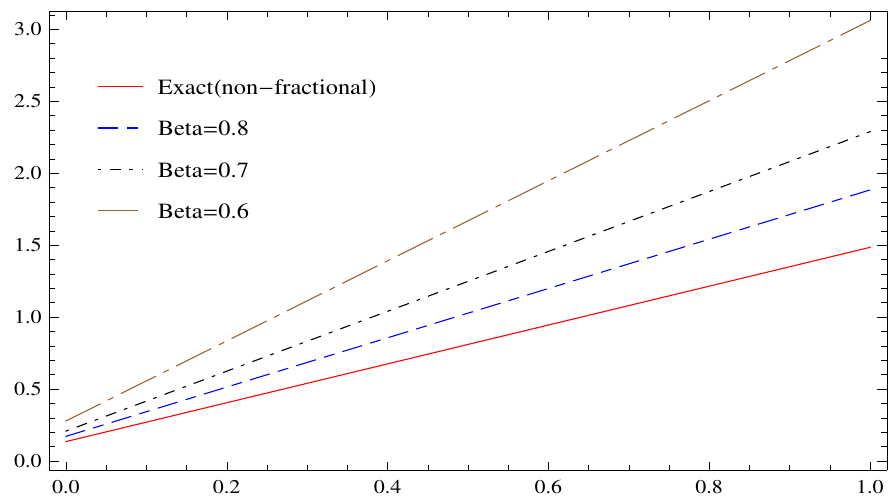
Figure 7. The FRDTM solutions f ( x , y , t ) for β = 1 ( exact (nonfractional) ) ,0.8,0.7,0.6; x ∈ [ 0,1 ] ; t = 0.1, and y = 0.1.